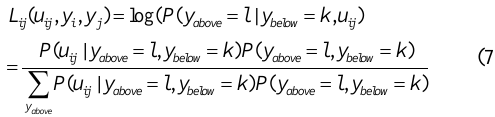
Figure 4. (a) Look-up table and (b) probability distribution of height difference when LMO is placed below the other